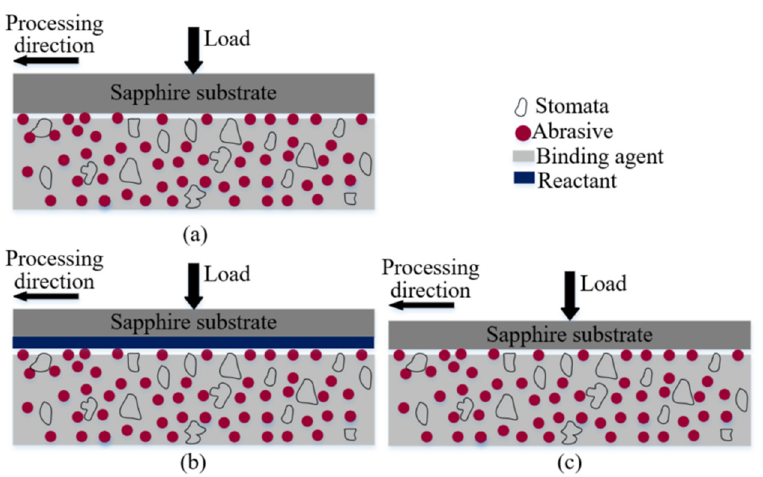
Figure 2. Diagram of polishing with semi-fixed soft abrasives: ( a ) Initial state of polishing ( b ) during polishing with reactant formation ( c ) during polishing with reactant removal.